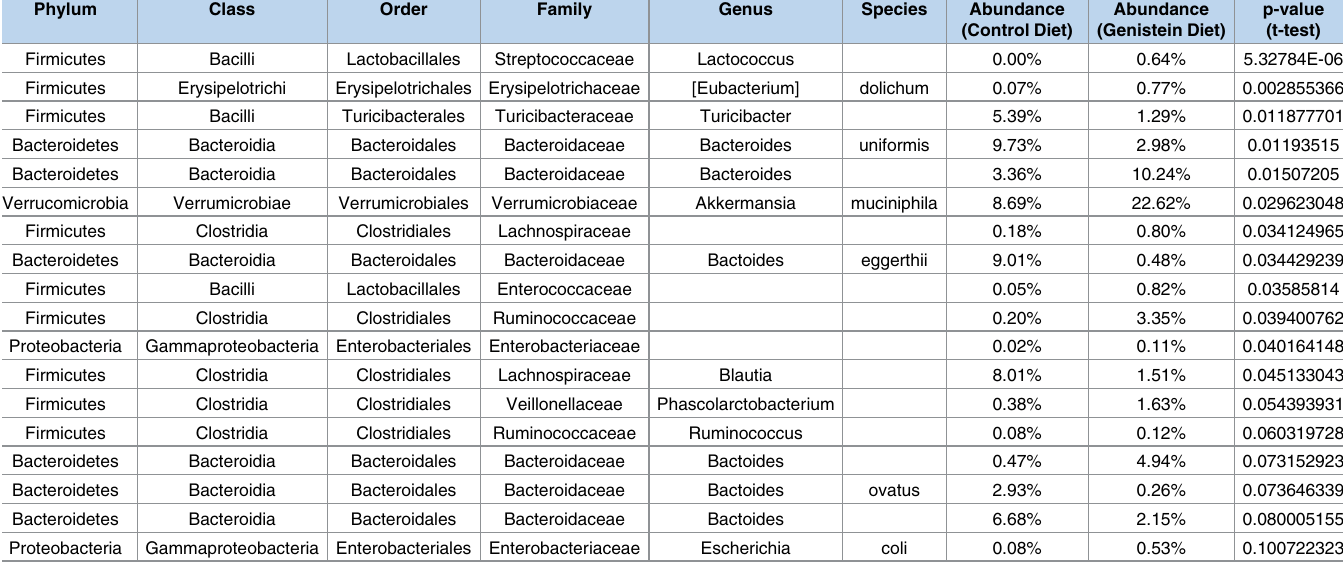
Table 2. Bacterial species showing significant changes in relative abundance after introduction of GE